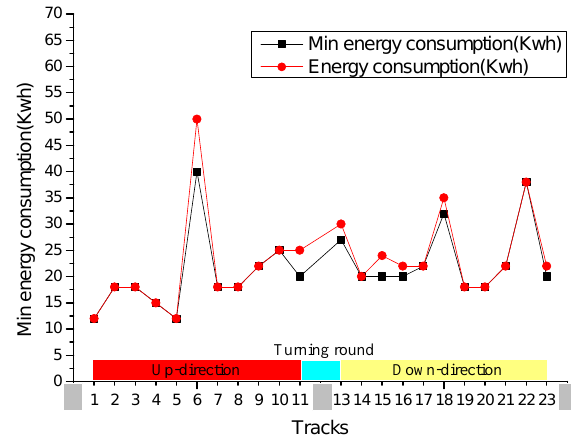
Figure 11. Energy consumption of each track under an energy consumption objective.